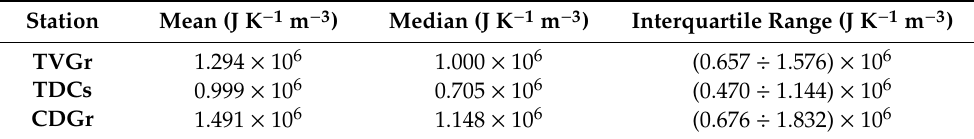
Table 3. The thermal capacity of the soil Cs for the three non-urban stations. Reference value for the soil layer between 5 and 50 cm of depth.